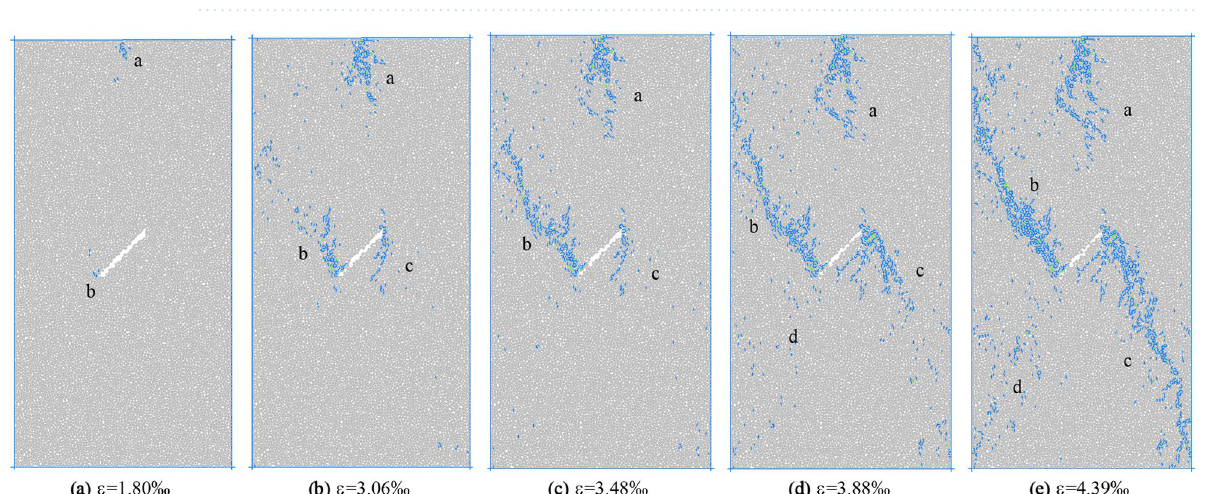
Figure 17. Crack evolution under biaxial compression under uniform load.